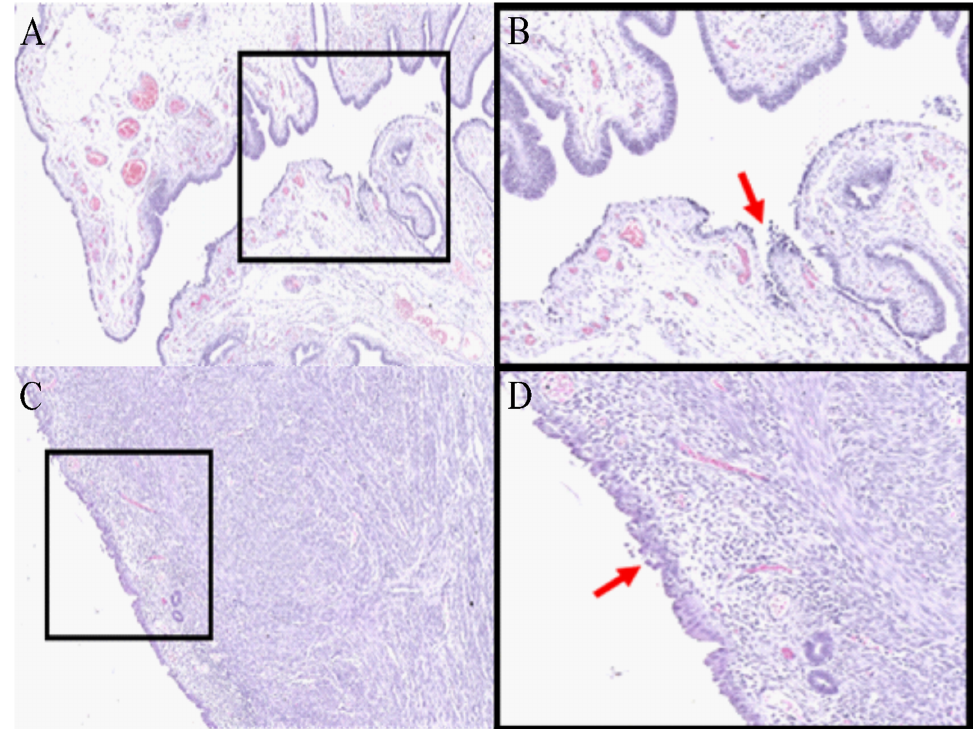
Figure 2. Hematoxylin and eosin-stained fallopian tube ( A , B ) and endometrium tissue ( C , D ) at 6× ( A , C ) and 12× ( B , D ) magnification. Areas of STIC ( B ) and EIC ( D ) are indicated by the red arrows. (Figure adapted, with permission, from “Proteomics Analysis of Serous Lesions of the Endometrium and Fallopian Tube Reveals Their Metastatic Potential”, Acland et al. (2020) [21]. 3.2. Laser Capture Microdissection and Protein Extraction for LC-MS/MS